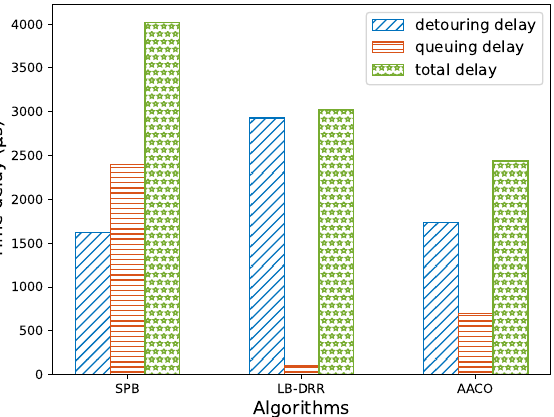
Figure 16. Comparison of the three algorithms when solving the same non-TT routing